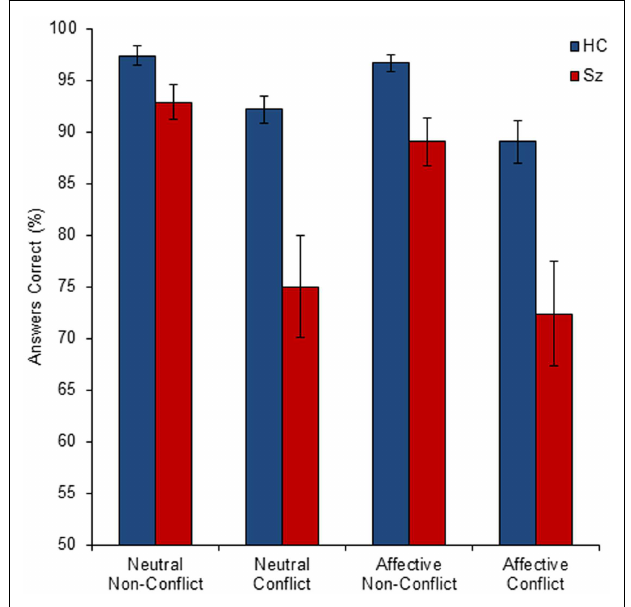
FIGURE 2 |The mean percentage of correct responses by group (HC, healthy control; Sz, schizophrenia), conflict status (conflict and non-conflict), and salience (affective and neutral) . Error bars show standard error of the mean (SEM). All between-group comparisons were statistically